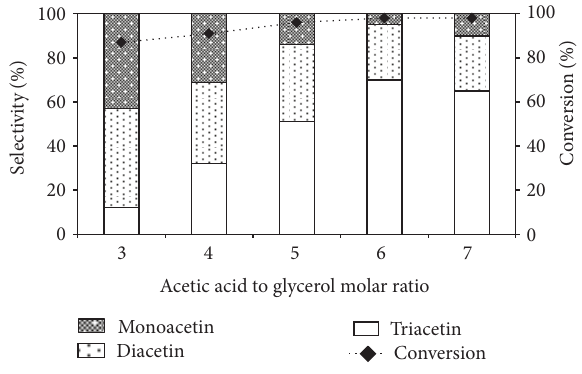
Figure 12: Influence of WO 3 loading on conversion and selectivity. (Reaction temperature: 110 ∘ C; reaction time: 10h; catalyst weight: 0.4 g; AcOH/Gly mole ratio: 6.)